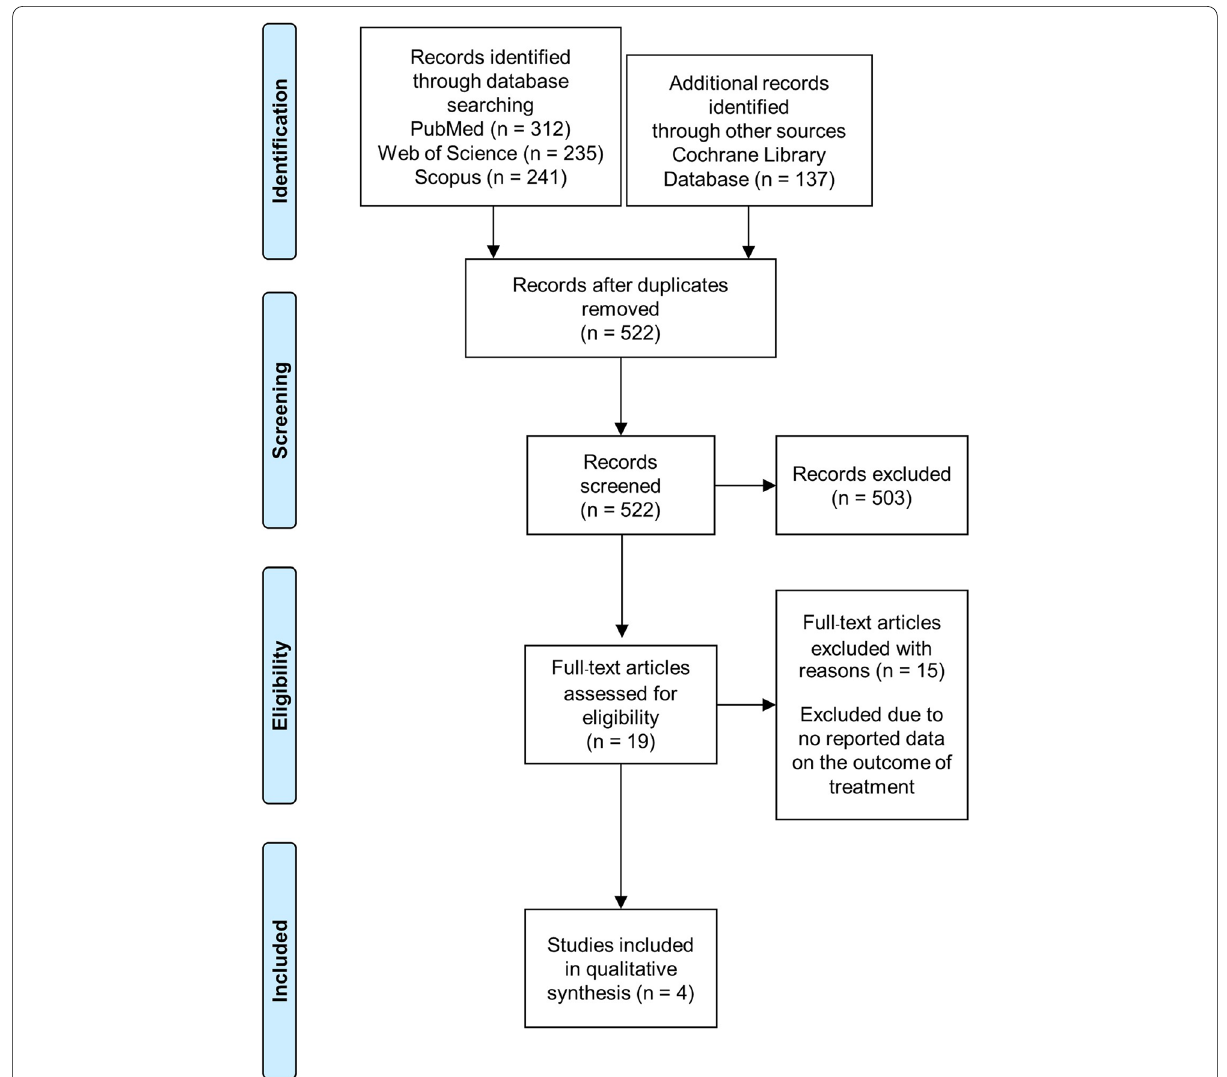
Fig. 1 The flowchart of study selection following the Preferred Reporting Items for Systematic Reviews and Meta-Analyses